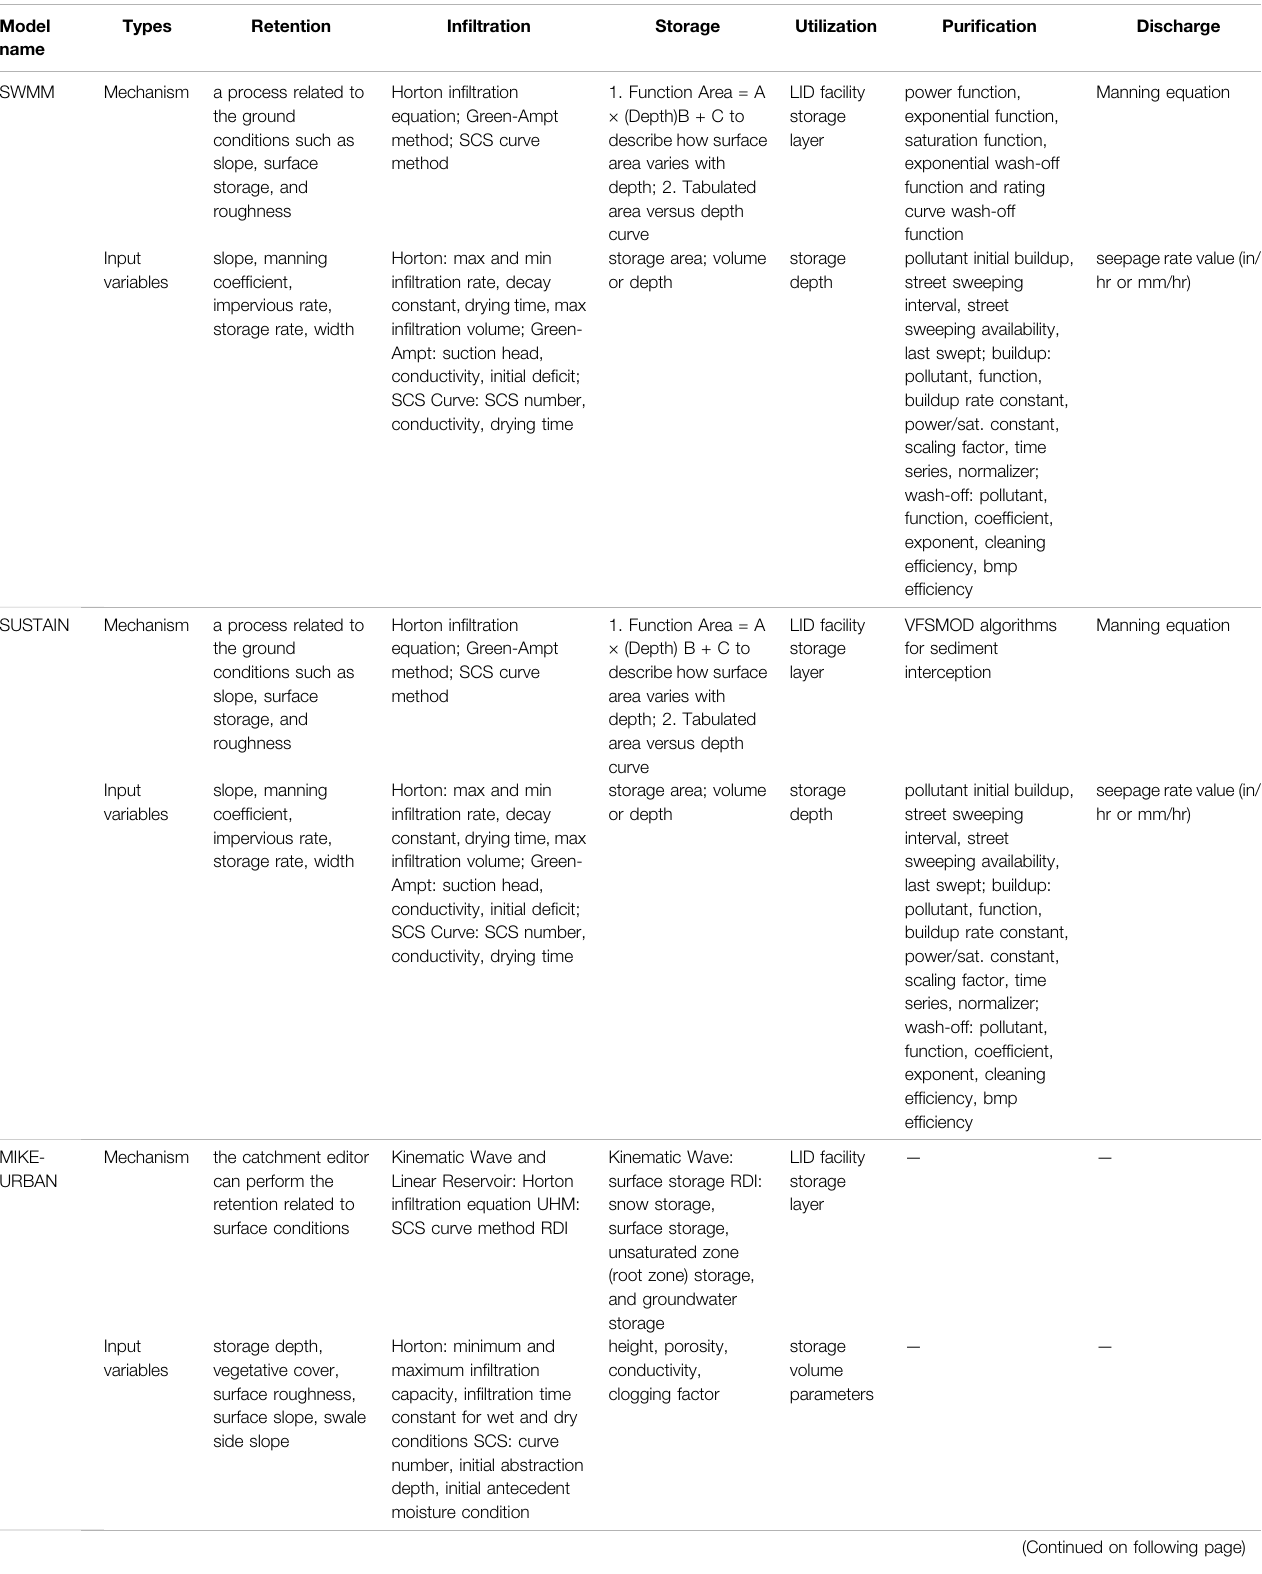
TABLE 1 | Comparison of the mechanisms and input variables of hydrological models in terms of the six mandated processes in sponge city